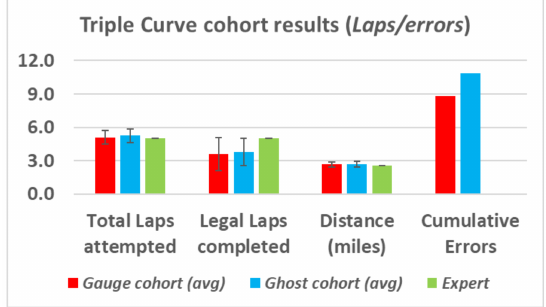
Figure 15. Triple Curve (laps/errors).